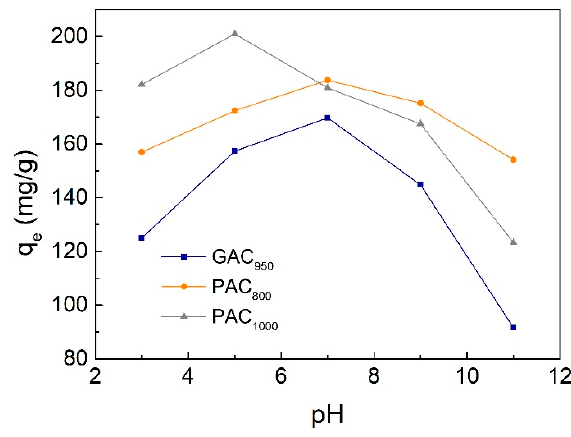
Figure 8. Effect of initial pH value on phenol adsorption onto AC. Figure 8. E ff ect of initial pH value on phenol adsorption onto